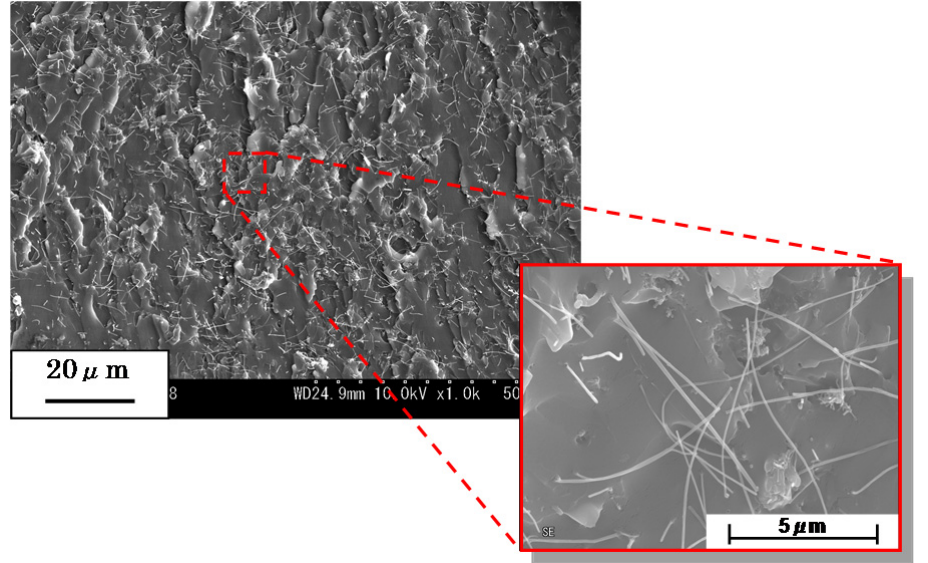
Figure 14. SEM images of MWNT-7/epoxy nanocomposite (2.0